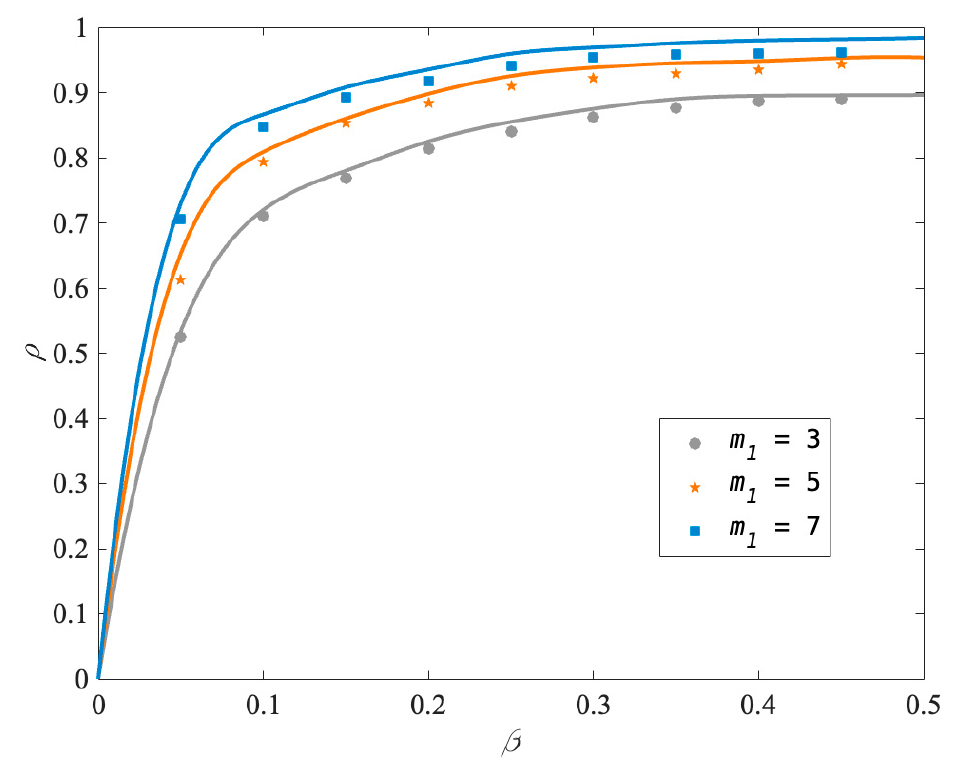
Figure 4. Densities of 𝜌 obtained by theoretical analysis and simulations in the stable state.